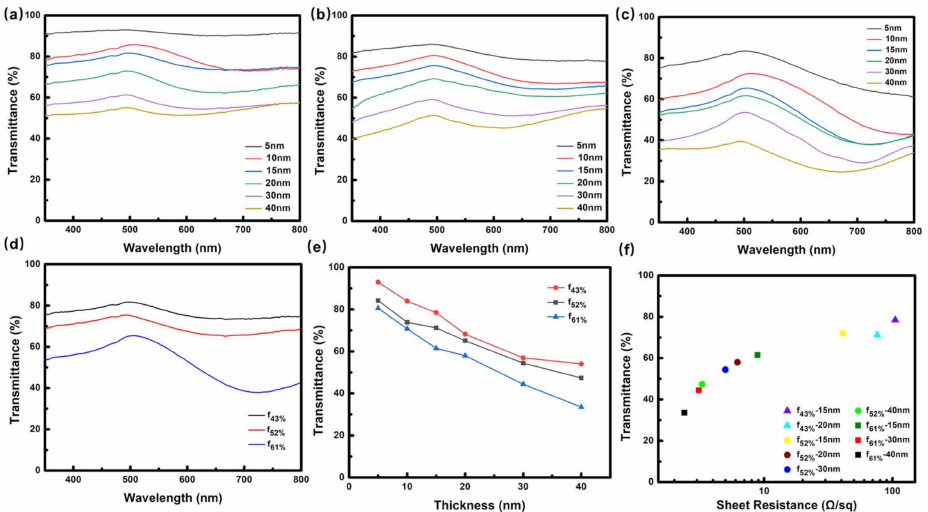
Figure 4. Optical transmittance (T) and sheet resistance (R S ) of Au nanomesh films on the flexible PET substrate with different parameters, namely, duty cycle and metal film thickness. Optical transmittance spectra for the ( a ) f 43% , ( b ) f 52% and ( c ) f 61% samples with various thicknesses. ( d ) Optical transmittance spectra of the 15 nm thickness samples with various duty cycles. ( e ) Optical transmittance comparison of Au nanomesh films with various metal film thicknesses and duty cycles. (wavelength at 550 nm) ( f ) Optical transmittance at 550 nm versus the corresponding sheet resistance for our Au nanomesh film samples (three pieces were made for each specific sample. The deviation of all samples were less than 1 Ω /sq).